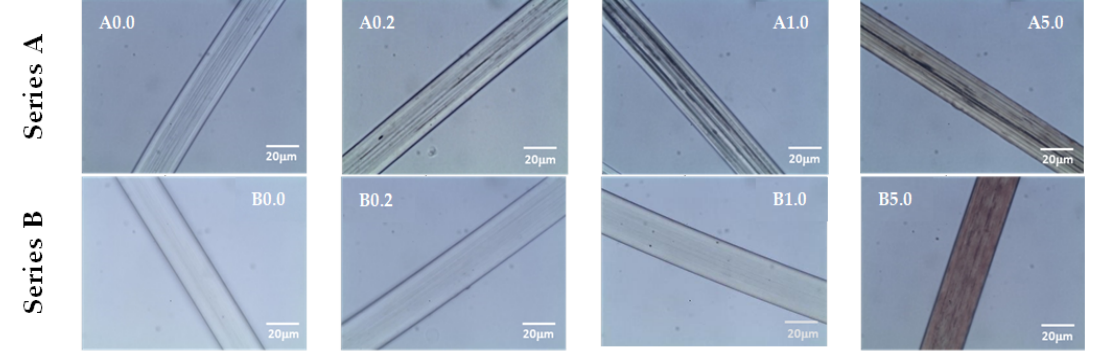
Figure 6. Optical microscopy images of fibres.